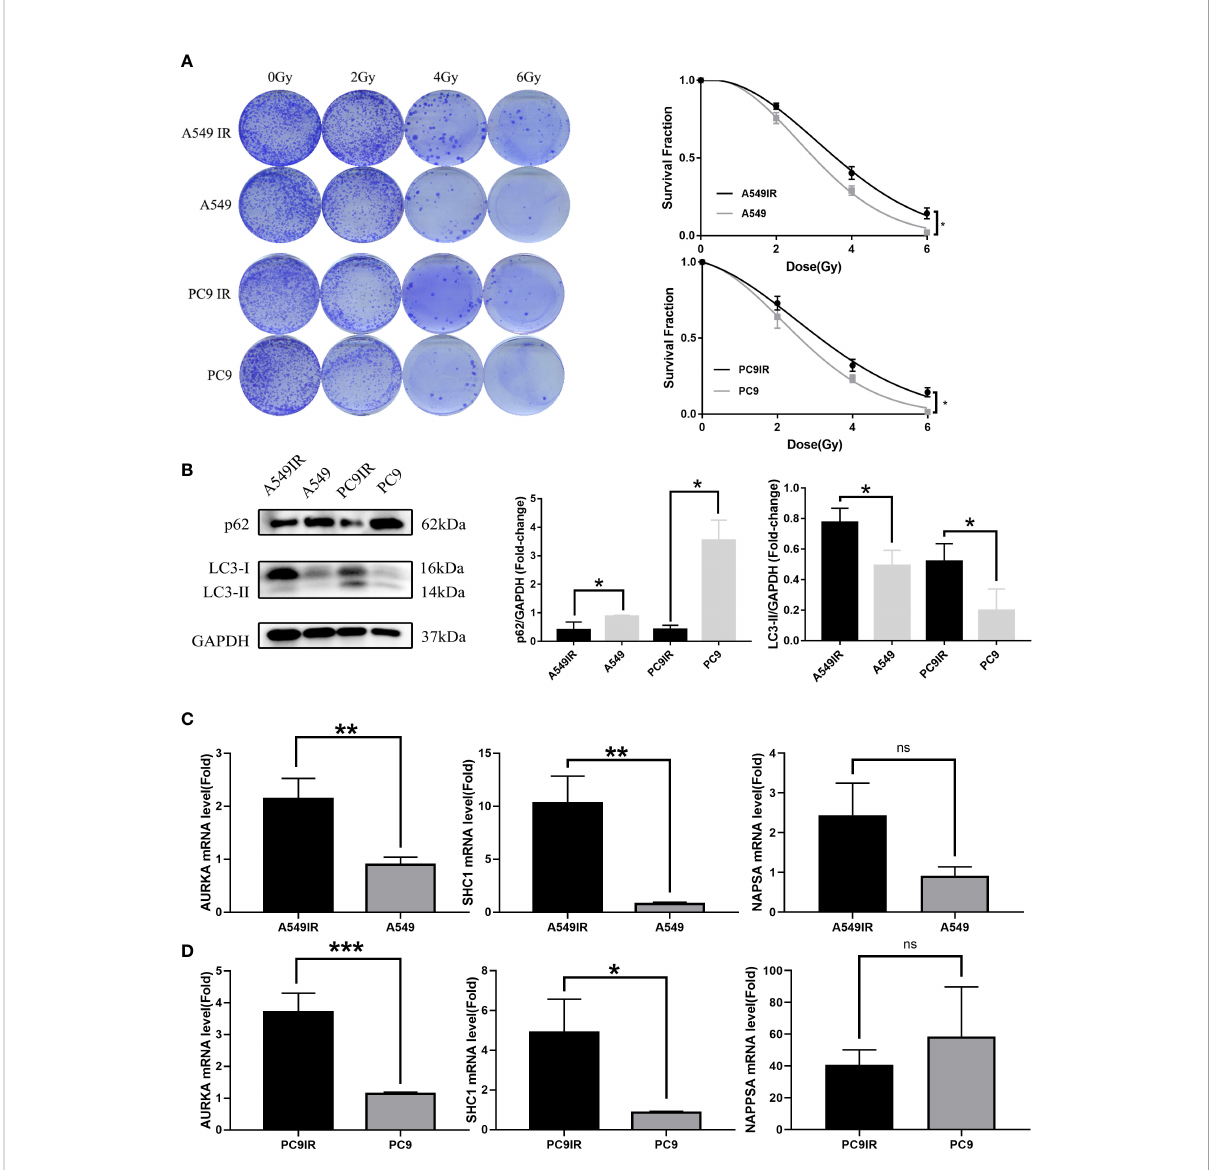
FIGURE 10 Validation of the relationship between AURKA, SHC1 , and NAPSA genes and radiotherapy sensitivity, and autophagy by constructing resistant cell lines compared with primary cells. (A) Colony formation assay reveal constructed resistance cells with enhanced radioresistance. (B) The western blotting assay showed increased levels of resistant cell autophagy. (C, D) Quantitative Real-time PCR veri fi ed signi fi cant differences in radiotherapy autophagy-related genes ( AURKA, SHC1 ) between radiotherapy-resistant and primary cells. *p < 0.05, **p < 0.01, and ***p < 0.001. "ns" indicates P value ≥ 0.05, not statistically signi fi